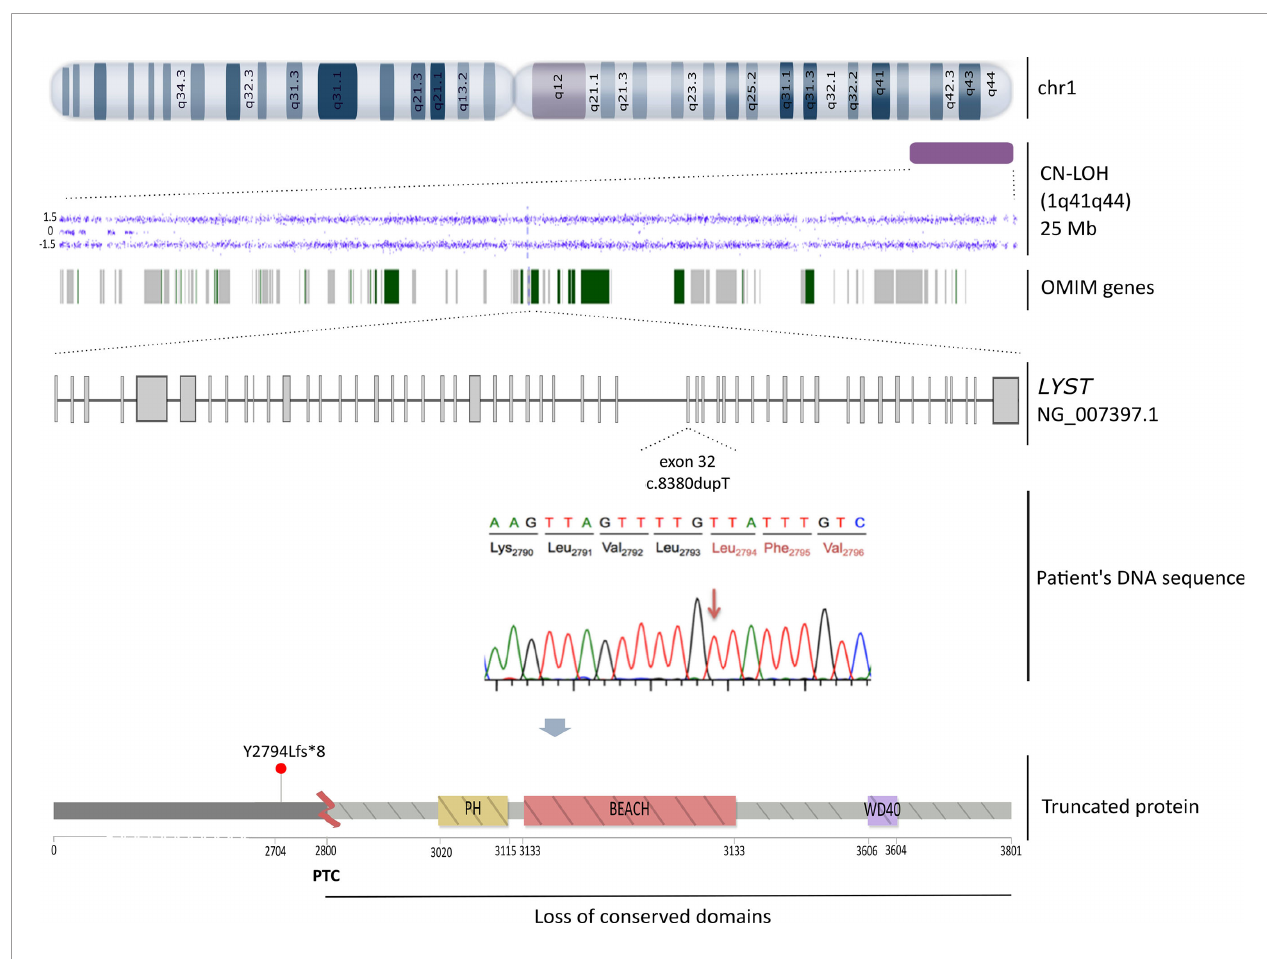
FIGURE 2 | Schematic representation of the triggering molecular mechanism of CHS in our patient. From top to bottom: the CN-LOH detected by SNP-array (Cytoscan HD, Affymetrix) in chromosome 1 (1q41q44) is delineated as a purple rectangle, the dots depict the altered markers in the array and the green and grey bands represent the 93 OMIM genes affected, including the LYST gene. Below, the LYST gene (NG_007397.1) that encodes for the entire functional protein is depicted. The c.8380dupT (NM_000081.3) frameshift mutation is localized in the exon 32. A lollipop-like (15) image re fl ects the resulting truncated protein owing to a PTC at 2,800 amino acid that would remove all conserved domains (PH, BEACH and